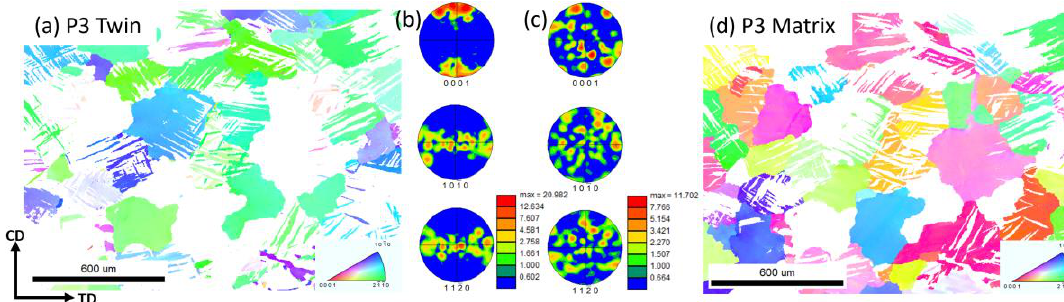
Figure 13. ( a , d ) The IPF Map and ( b , c ) corresponding PF of the twin and the matrix of P3.